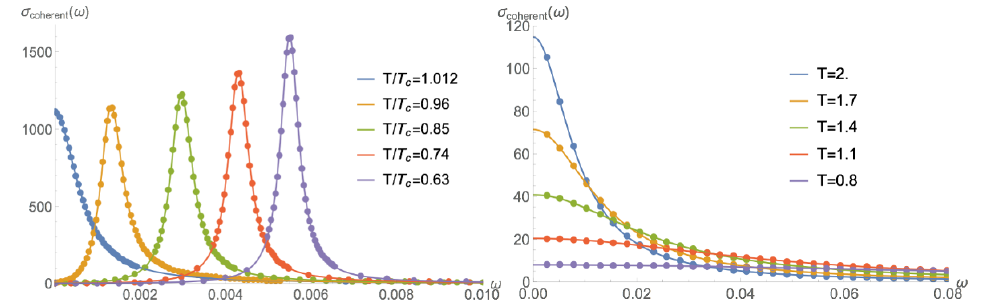
Figure 9 . Coherent conductivity for the pinned spontaneous (2.11) (left) and explicit (2.8) (right) cases as a function of frequency. We show the numerical results as data points and corresponding (cid:12)ts to the models (6.2), (6.3) with solid lines.